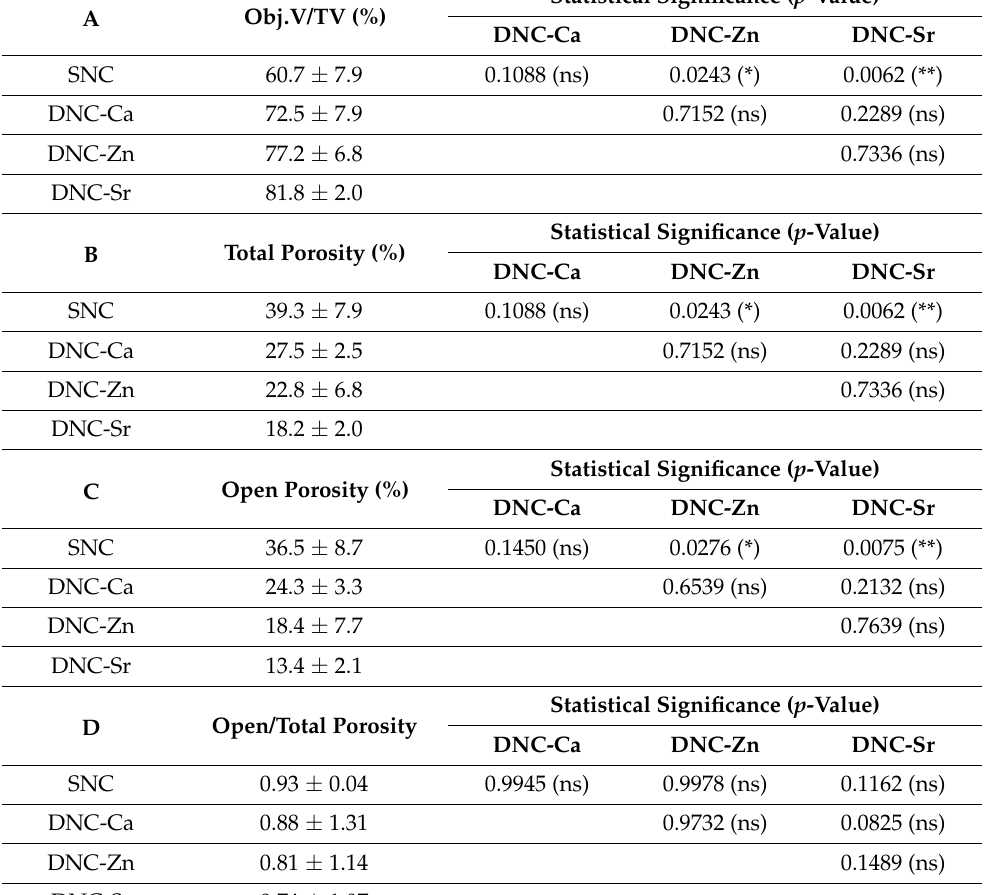
In the 3D µ CT images, DNC’s show evidence of porosity (Figure 4(B1,B2)) with a denser structure (Table 5) and lower total and open porosity (Table 5) compared to the SNC. Among the DNC’s, DNC-Ca exhibits a higher porosity than DNC-Sr or DNC-Zn. All DNC’s demonstrates near zero degree of anisotropy of the DNC’s (Table 5), suggesting that these materials are isotropic. Table 5. (A) Object volume/total volume (Obj.V/TV), (B) total porosity, (C) open porosity, (D) open/total porosity and (E) degree of anisotropy of dual network composites chelated with Ca 2+ (DNC-Ca), Zn 2+ (DNC-Zn) and Sr 2+ (DNC-Sr) compared to the single network composites (SNC) in the hydrated state quantified from micro-computed tomography ( µ CT) results. Data are displayed as mean ± SD ( n = 3). Statistical significance was verified with one-way ANOVA and post hoc Tukey’s analysis (ns: not significant, * p < 0.05 and ** p ≤ 0.01).